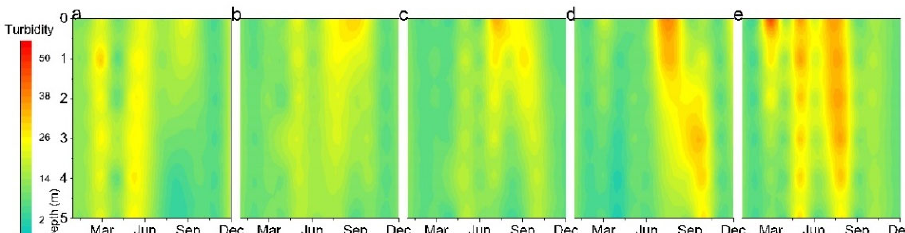
Figure 7. Spatiotemporal variation in turbidity in Lake Xingyun, measured during 2017. ( a ) XYH ‐ 1. ( b ) XYH ‐ 2. ( c ) XYH ‐ 3. ( d ) XYH ‐ 4. ( e ) XYH ‐ 5.